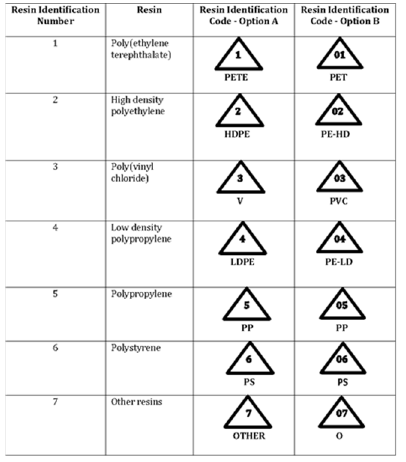
Figure 1. Resin identification codes. Source [25,26].